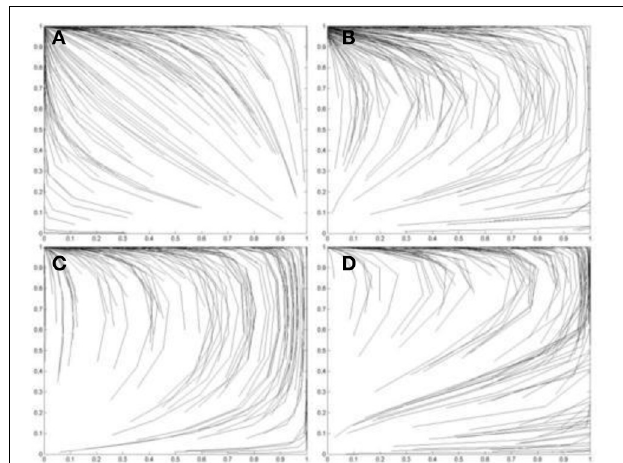
FIGURE 10 | Simulations of one hundred pairs of agents playing thirty iterations of (A) the Prisoner’s Dilemma game; (B) the Leader game; (C) the Chicken game; and (D) the Battle-of-the-Sexes game. In each simulation, one agent in each pair has I ∗ 1 = 3 . 9 and the other has I ∗ 2 = 1 . 1. Initial values of p C and q C are randomized. See Figure 5 for